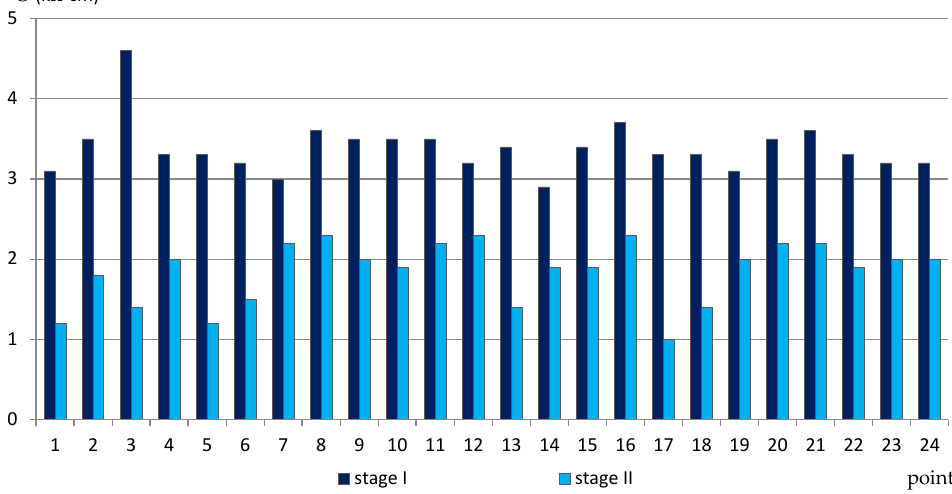
Figure 14. Concrete cover resistivity measured in C_III_n specimens.